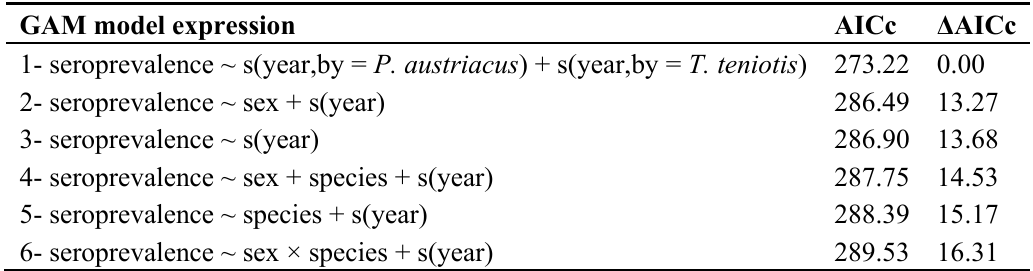
Table 6. Model building results for the generalized additive models (GAM) relating EBLV-1-antibody prevalence and explanatory